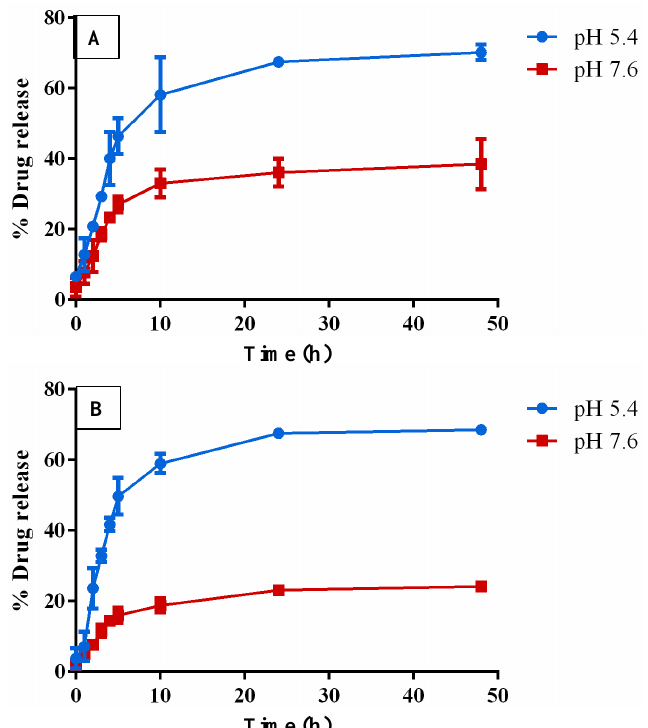
Figure 6. In vitro drug release studies of ( A ) PGMD-DG 7:3, and ( B ) PGMD-DG 6:4 at different pH under varying time intervals.